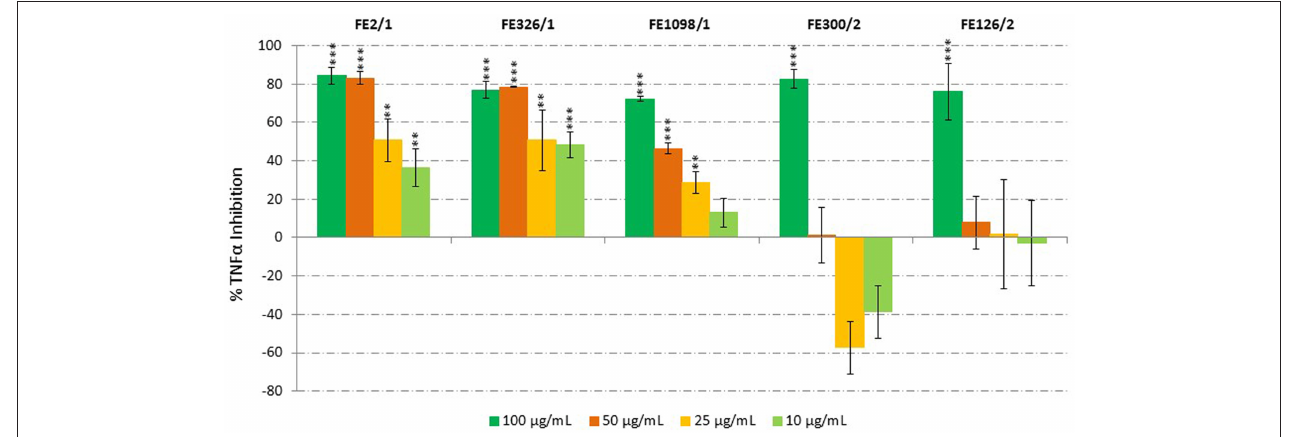
FIGURE 2 | Anti-Inflammatory Assay. Inhibition of TNF α secretion from LPS-stimulated THP-1 cells treated with extracts of Cylindrotheca closterium (FE2/1), Odontella mobiliensis (FE326/1), Pseudonitzschia pseudodelicatissima (FE1098_1/1), Coscinodiscus actinocyclus (FE300/2), and Alexandrium minutum (FE126/1) (n = 9, data represent means for 3 biological and 9 technical triplicates; ** for p < 0.01 and *** for p < 0.001, Student’s t -test) compared to control.